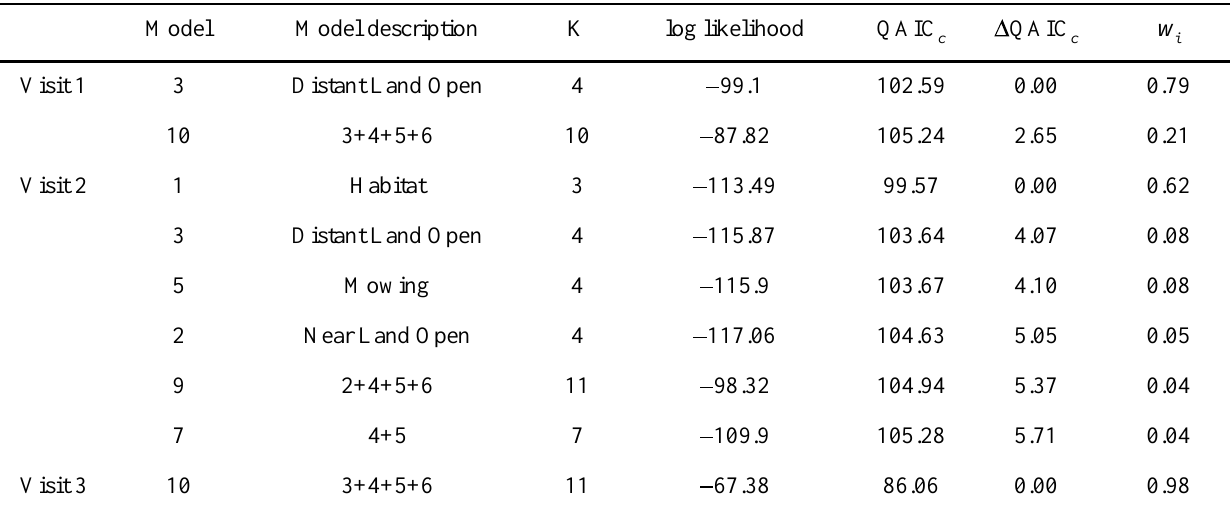
Table 4. QAIC rankings, number of parameters (K), log likelihoods, QAIC c ) for Poisson regression models reflecting hypotheses of habitat use for point count data on male Bobolink ( w i abundance conducted between May 21 and July 2, 2002 in the Champlain Valley of Vermont and New York. Only models included in the 90% confidence set are